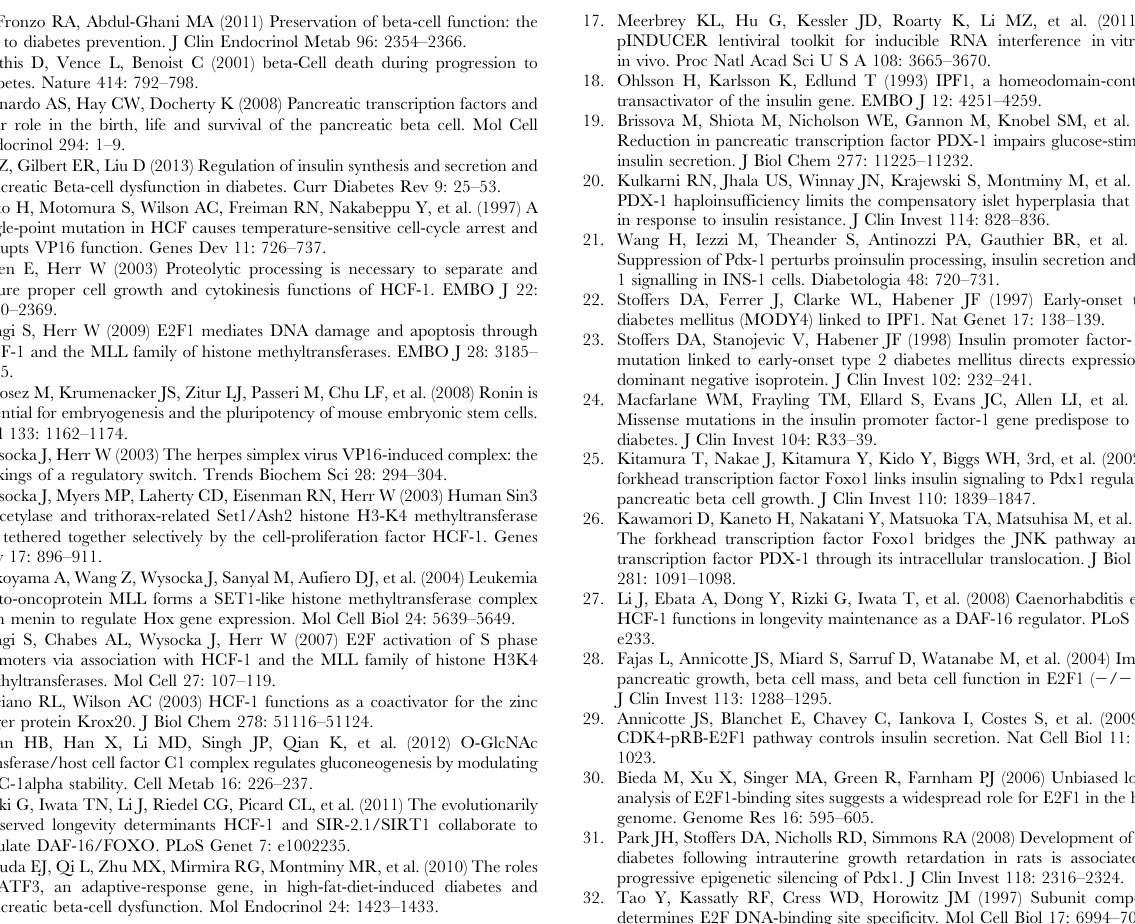
Figure S2 HCF-1 knockdown reduces expression of E2F1 target genes. Table S1 Sequences of PCR primers